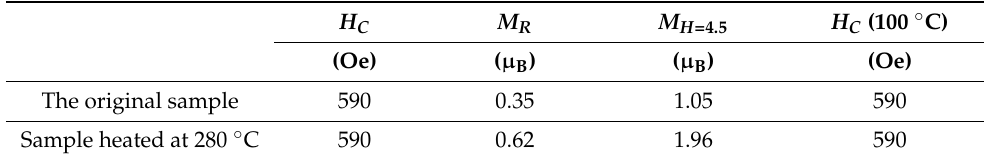
Table 8. Values of residual magnetization ( M R ), magnetization in the field of 4.5 kOe ( M H =4.5 ), and coercive force ( H C ) at room temperature and at 100 ◦ C for the initial and calcined samples. H